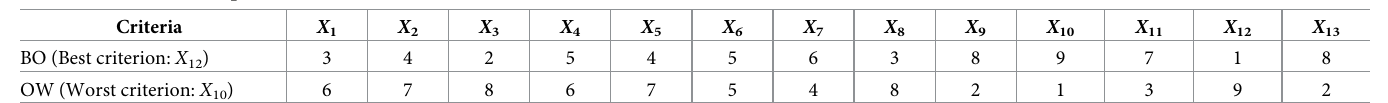
Table 3. Decision-maker preferences.